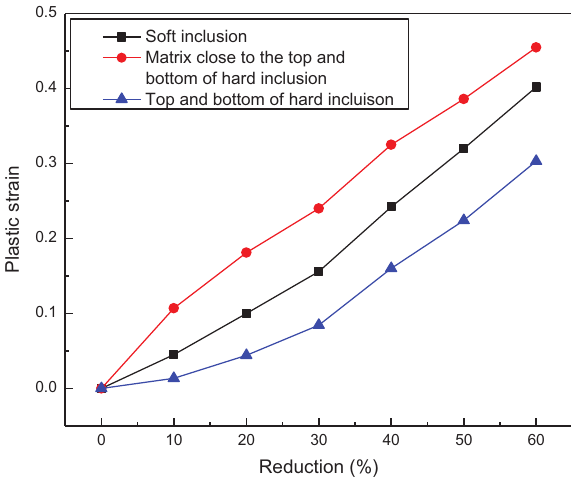
Figure 5: Plastic strain of inclusions and matrix after different reductions.